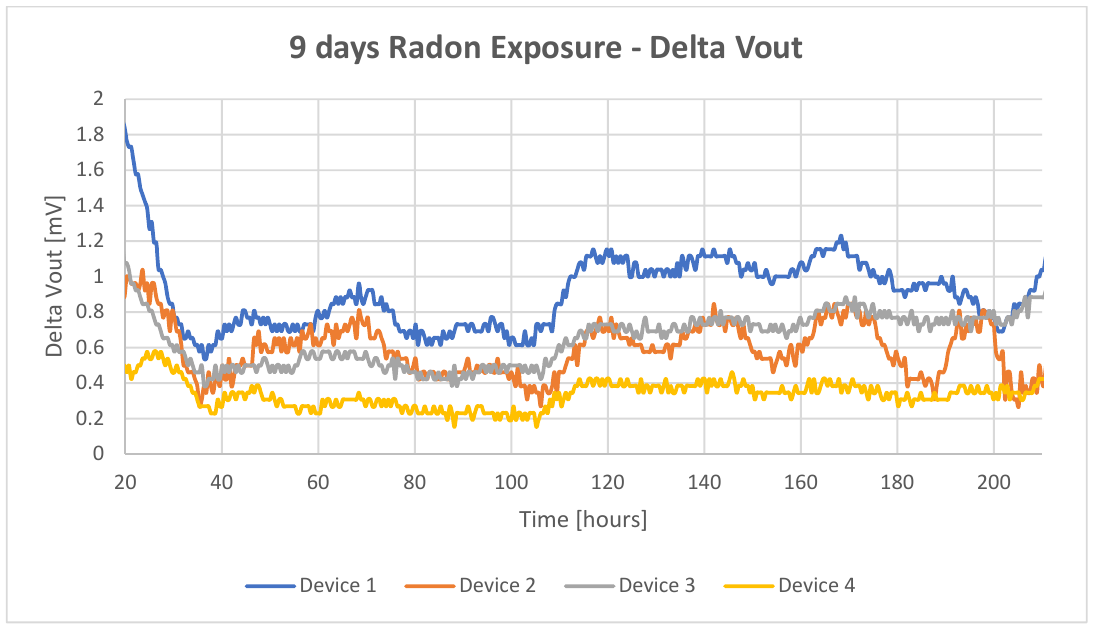
Figure 11. Readout voltage derivative.